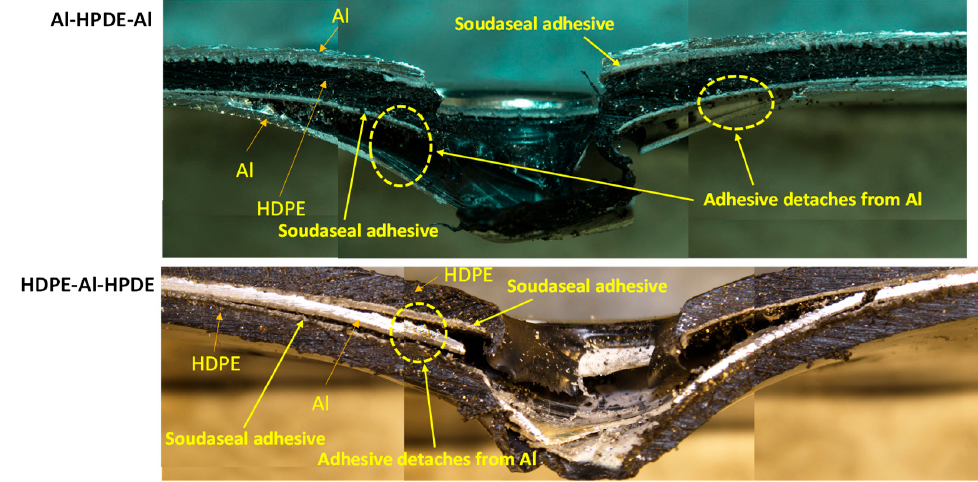
Figure 15. Cross-sectional view of the failure modes of tri-layer laminates under the blunt indenter.